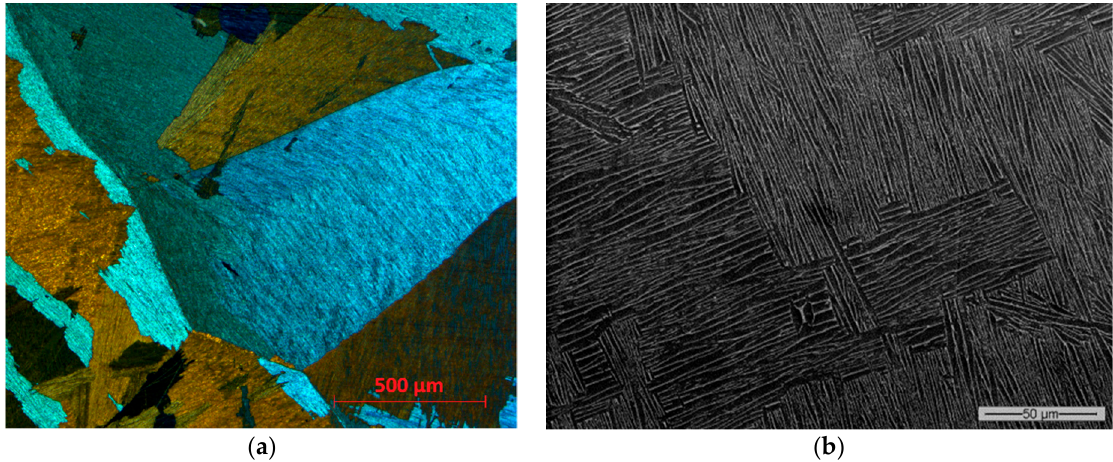
Figure 6. Lamellar microstructure obtained with annealing temperature T β + 25 °C for 3 h, viewed with polarized optical microscopy ( a ) and SEM ( b ).